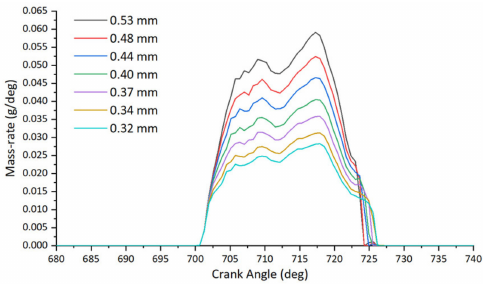
Figure 21. Fuel injection rate under varied nozzle